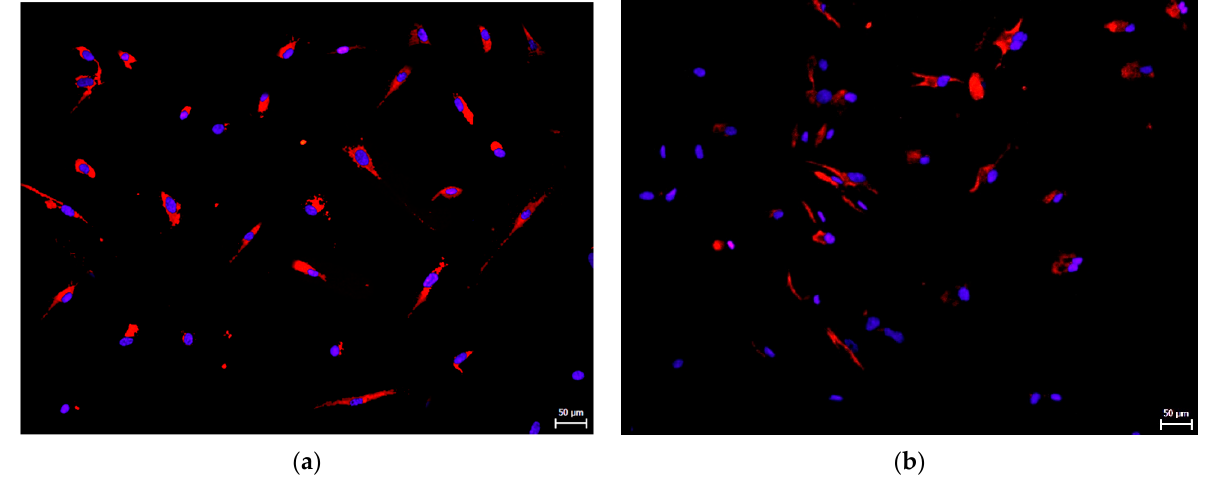
Figure 7. Immunocytochemical detection of neurofilaments, the late neuronal marker, in undifferentiated hNDP-SCs harvested in the 7th passage. Most cells were positive for neurofilaments (red fluorescence). Cell nuclei fluorescent blue. Scale bare 50 μ m: ( a ) hNDP-SCs cultivated in the FBS-culture medium; ( b ) hNDP-SCs cultivated in the hPL-culture medium.